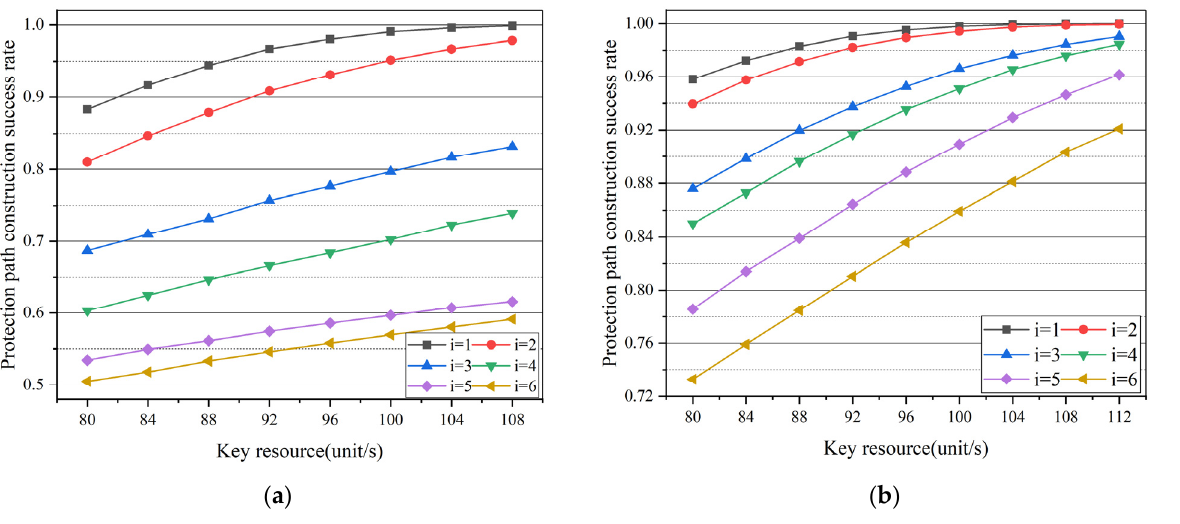
Figure 10. Simulation results: ( a ) protection path construction success rate varies with key resource in the case of different untrusted node numbers in NSFNET; ( b ) protection path construction success rate varies with key resource in the case of different untrusted node numbers in USNET.